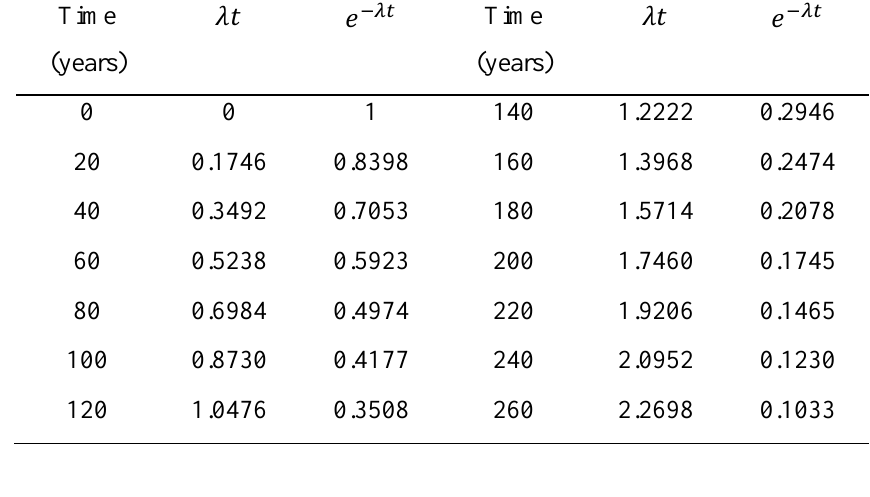
Reliability using CFR.